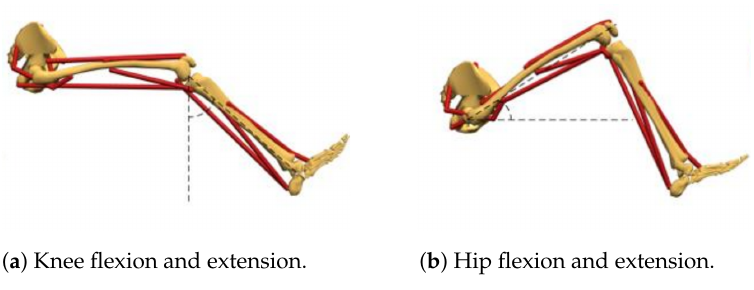
Figure 1. Rehabilitation posture. Table 2. Motion range of lower limb joints in sitting